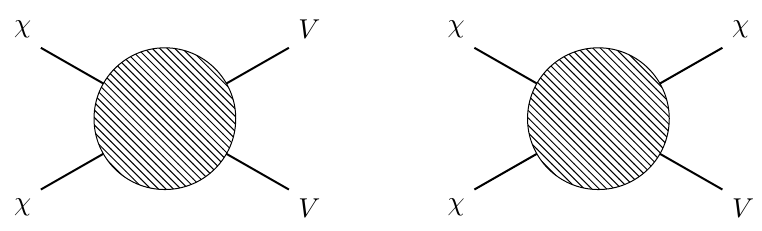
Figure 1 . Two types of dark sector-visible sector interactions, where (cid:31) ( V ) is any dark (visible) (cid:12)eld. (Left): DM annihilation to/from, or scattering o(cid:11), the SM; this is the only possibility when the DM is stabilised by a Z 2 symmetry. (Right): semi-annihilation, a non-decay process with an odd number of external dark (cid:12)elds, generically possible when the stabilising symmetry is not a Z 2 . We show 2 ! 2 processes for illustrative purposes (and because they typically dominate), but any number of (cid:12)nal states are